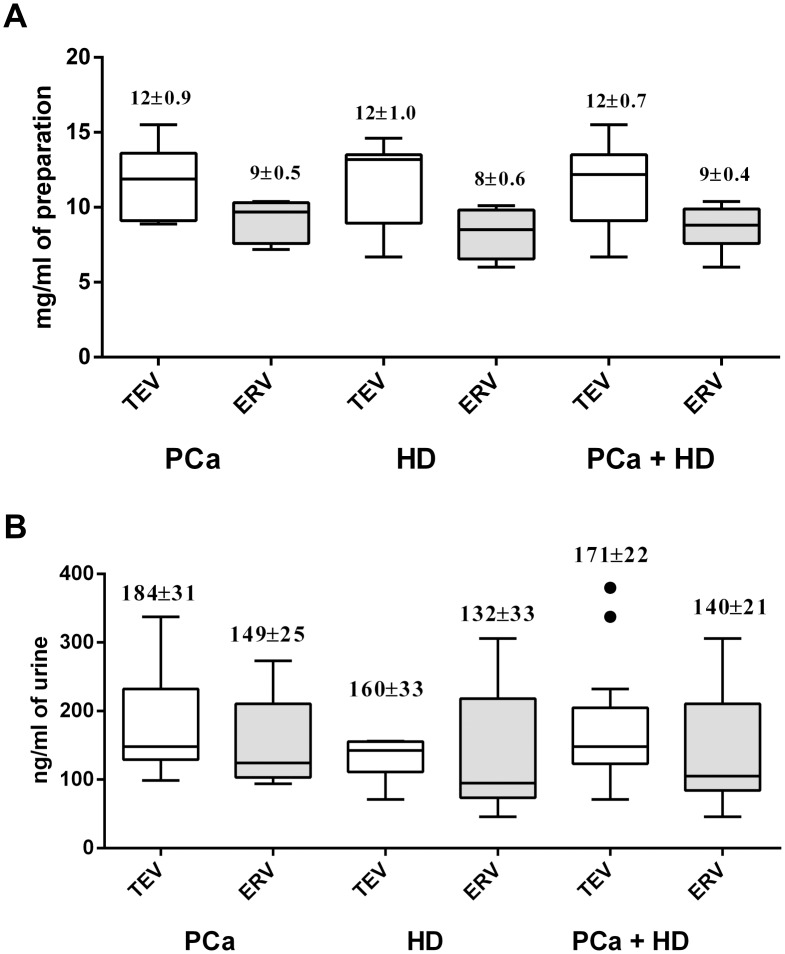
Protein concentration in urine EVs.Tukey box plots of concentration of total protein in preparations of EVs isolated from the urine of PCa patients and HD were determined using NanoOrange fluorescent dye and presented as mg per ml of probe (A) or ng per ml of urine (B).